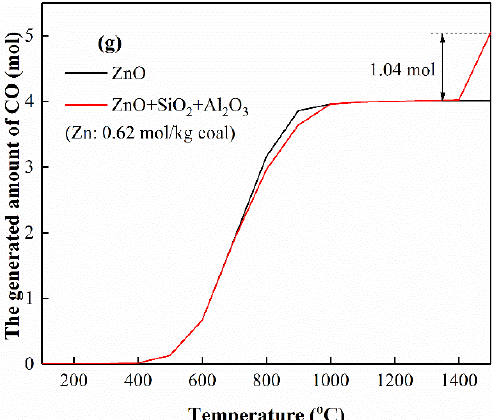
Figure 12. The thermodynamic equilibrium distributions of Zn ( a , b ), Si ( c , d ), Al ( e , f ) and generated amount of CO ( g ) when Zn, Si and Al coexist in the coal.